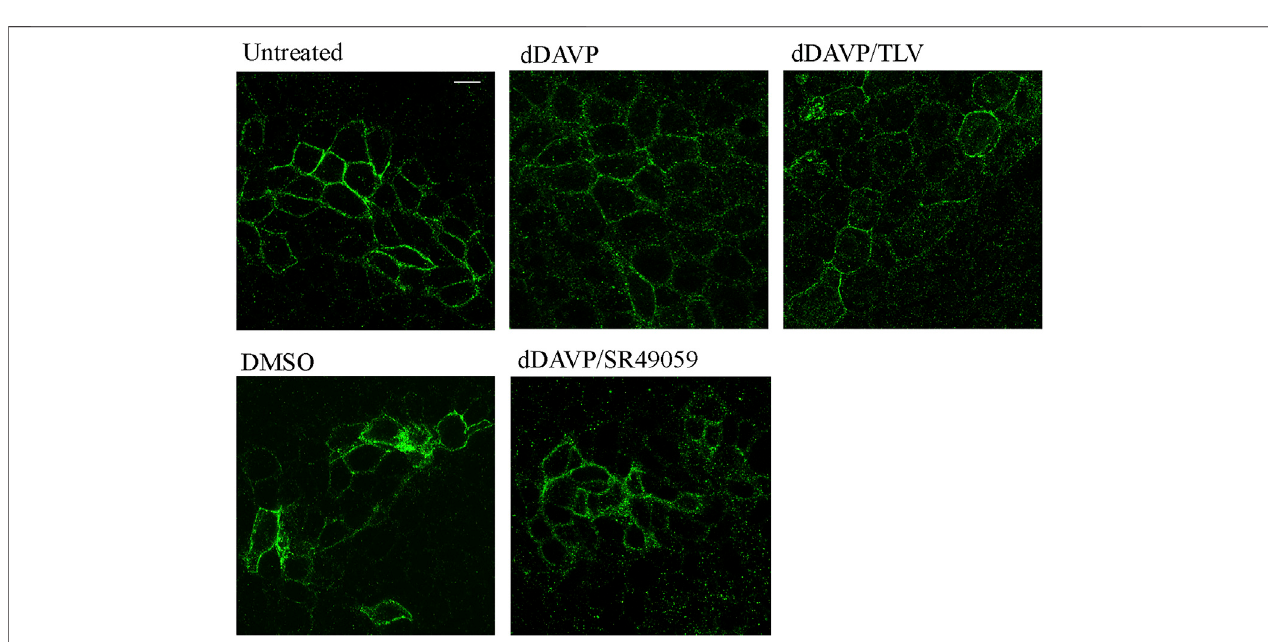
FIGURE 5 | Immuno fl uorescence localization of AQP3 in HCT8 cells. HCT8 cells were treated (as described in the methods section), stained for AQP3, and subjected to confocal laser scanning microscopy. Under basal conditions, AQP3 staining was mainly in the plasma membrane. Treatment with dDAVP or with dDAVP and tolvaptan caused a slight reduction of the AQP3 membrane localization. Bar = 10 µm.